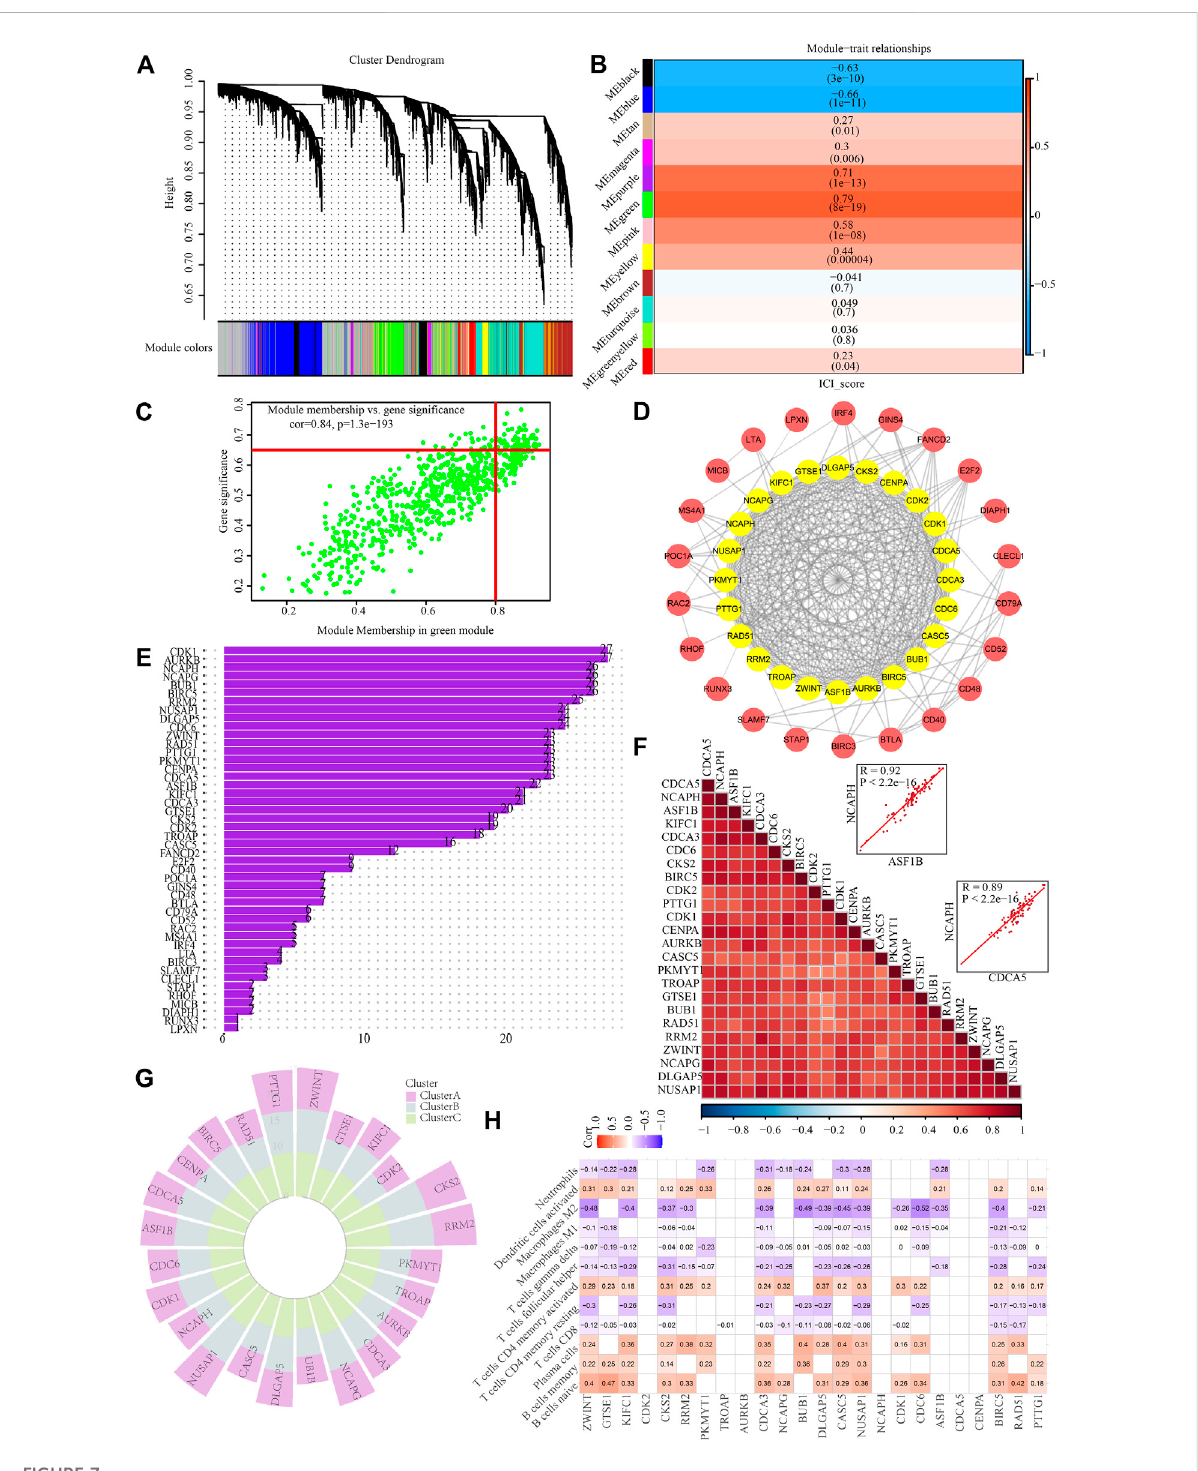
FIGURE 7 Identi fi cation of hub genes based on ICI scores. (A) Identi fi cation of co-expression modules for WGCNA analysis. (B) Correlation heat map of modules and differentially immuno-in fi ltrated cells. (C) Green module screening for core genes. (D) PPI network analysis. (E) protein counts of PPI analysis. (F) Hub gene correlation. (G) Expression traits of hub genes in different ICI subgroups. (H) Correlation between hub genes and immune cell in fi ltration in